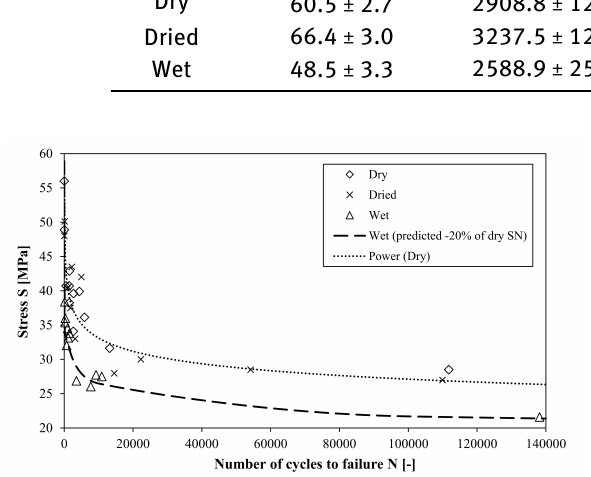
Figure 7: S-N curves of initial (dry), saturated and dried epoxy speci- mens in linear